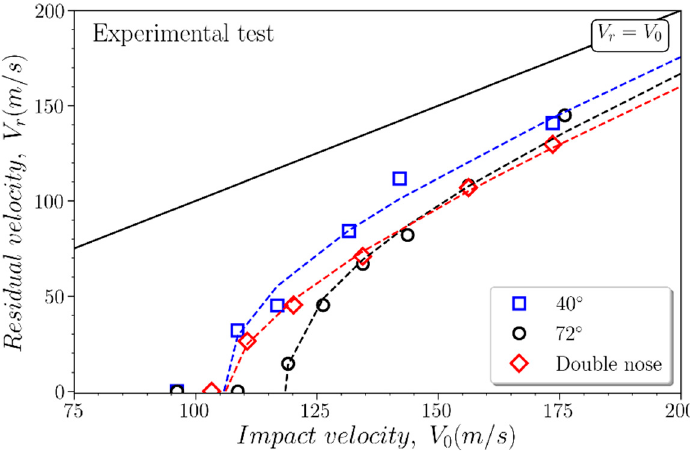
Figure 4. Residual velocity, V r , versus impact velocity, V 0 , for the di ff erent projectiles. Figure 4. Residual velocity, 𝑉 (cid:3045) , versus impact velocity, 𝑉 (cid:2868) , for the different projectiles. Figure 4. Residual velocity, 𝑉 (cid:3045) , versus impact velocity, 𝑉 (cid:2868) , for the different projectiles.